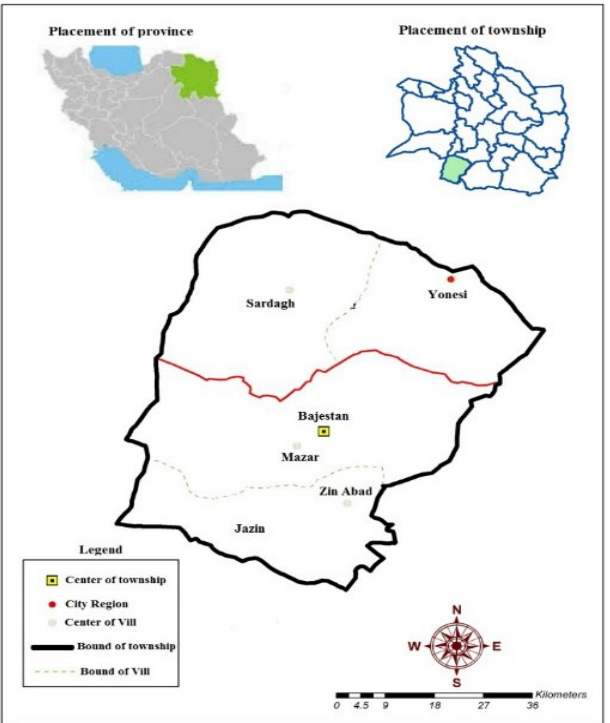
Figure 2. Geographical location of the Bajestan Plain in Razavi Khorasan province, Iran.